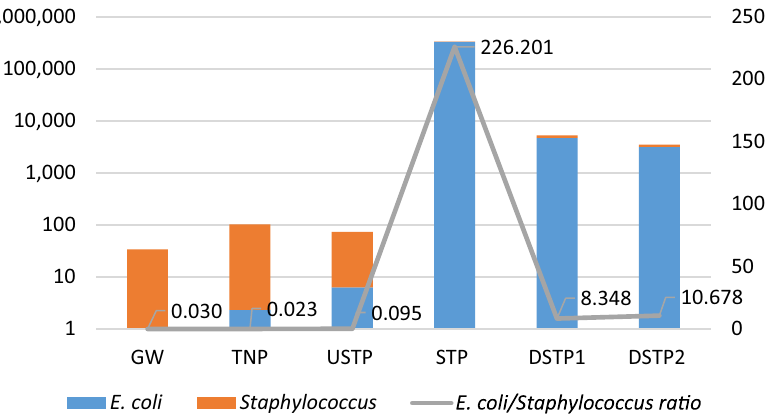
Figure 1. Mean concentrations (CFU/100 ml) of E. coli and Staphylococcus spp. in water, and changes in the E.coli / Staphylococcus spp. ratio along the course of the Białka river. Site abbreviations are as follows: GW— groundwater; TNP—Tatra National Park; USTP—upstream of the sewage treatment plant; STP—sewage treatment plant; DSTP1—c.a. 3 km downstream of the STP; DSTP2—c.a. 7 km downstream of the STP (for detailed description, please see caption of Fig.